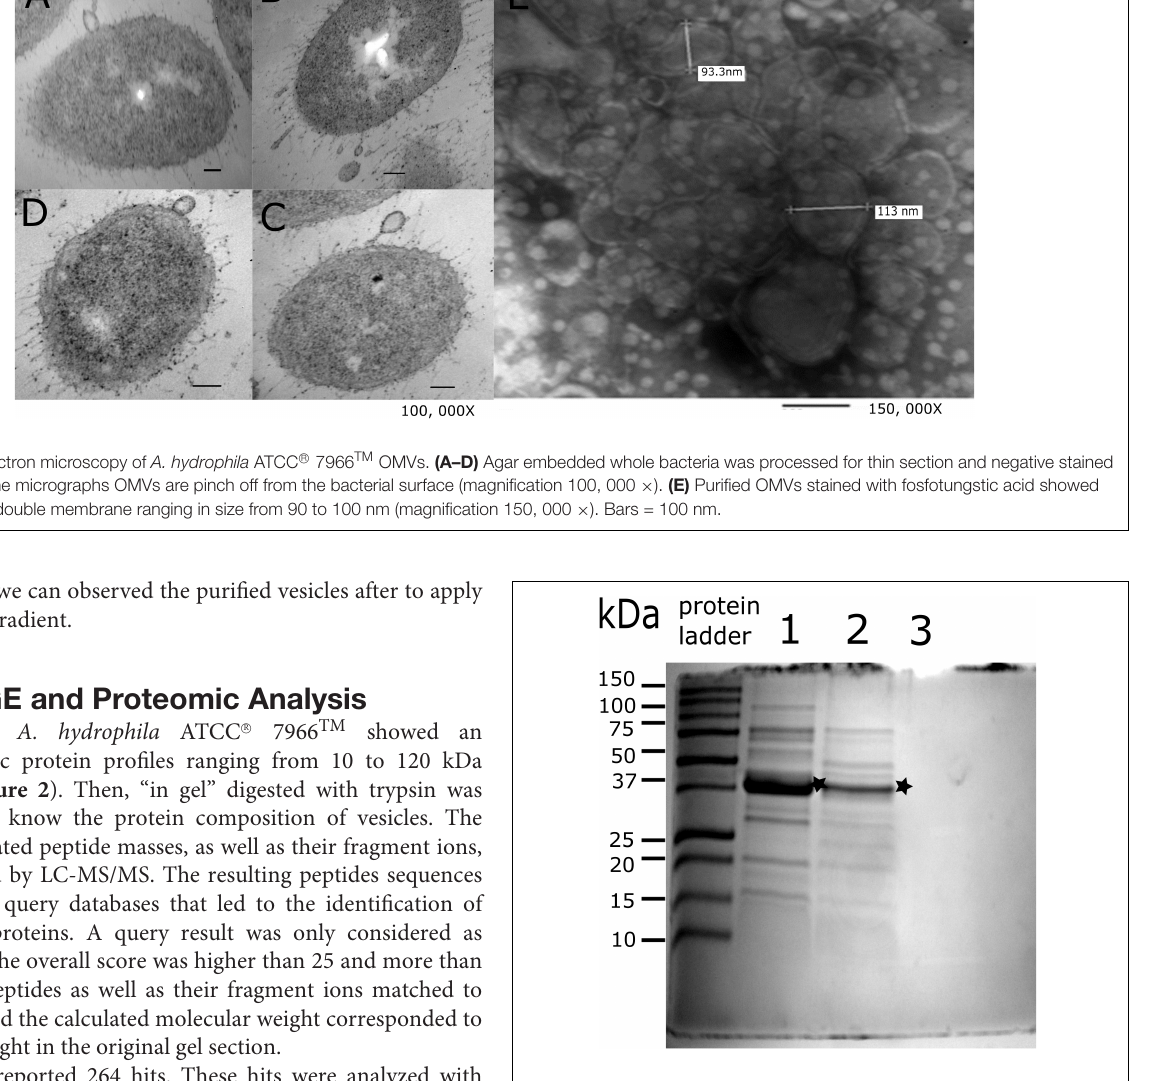
FIGURE 2 | Protein profile of A. hydrophila ATCC R (cid:13) 7966 TM OMVs. OMVs were purified by differential centrifugation and loaded onto 12.5% Acrylamide gel for electrophoresis. Lane 1; purified OMVs by ultracentrifugation at 150, 000 × g , during 2 h. Lane 2; OMVs purified by Optiprep gradient centrifuged at 150, 000 × g , during 16 h. 25 µ g of protein of OMVs were loaded on each well. Lane 3; PBS from the second step-wash of purified vesicles. ∗ Protein of approximately 42 kDa which could correspond to flagellar body